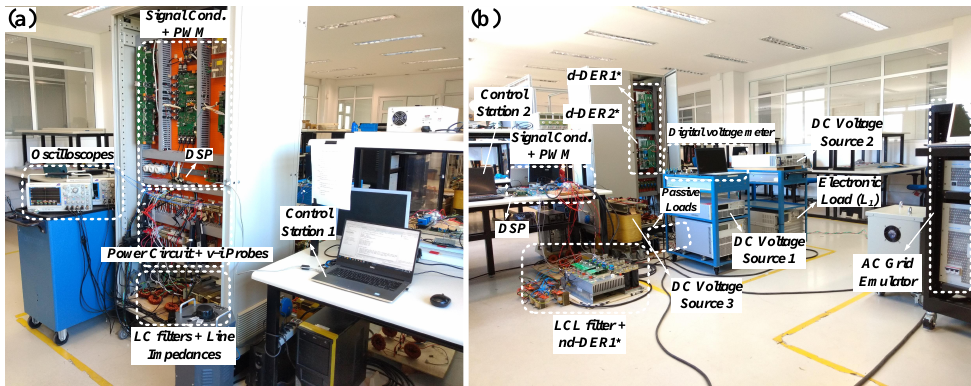
Figure 8. Experimental prototype of the single-phase MG: ( a ) front and ( b ) back